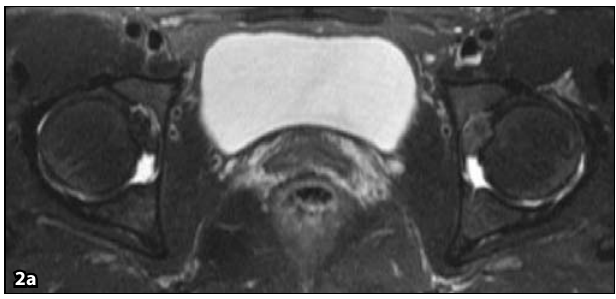
Fig. 2. Serial axial fat-suppressed proton density MRI